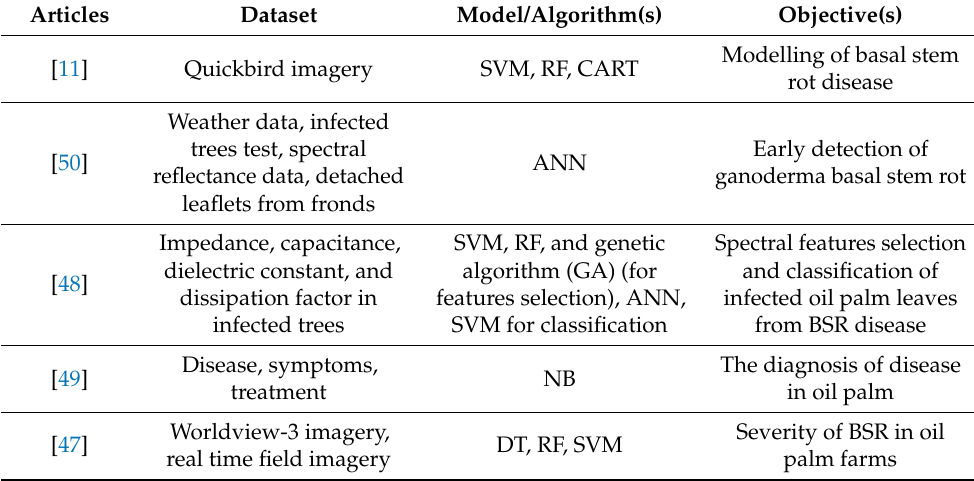
Table 3. Disease